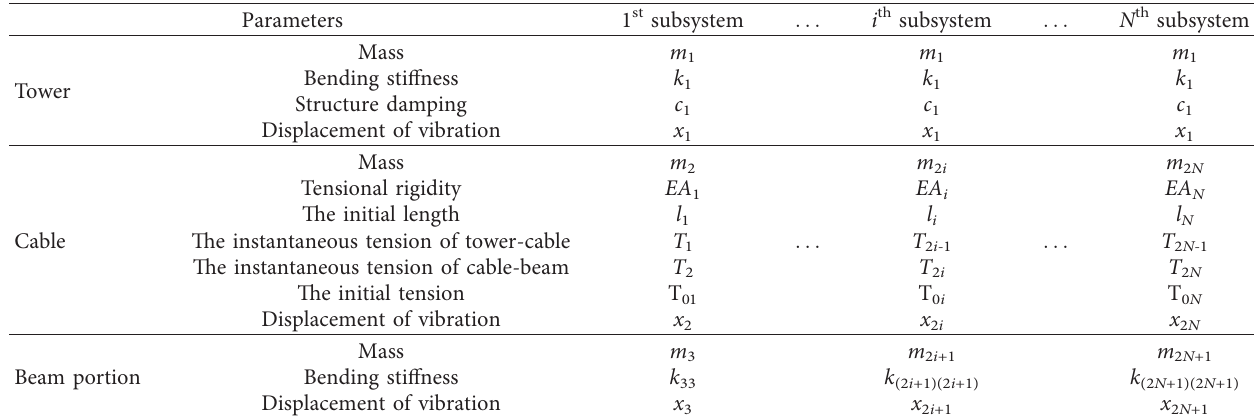
Figure 4: The simplified model for the parametric resonance of the multicable system in cable-stayed bridges. Table 1: Parameters of the refined model (0 ≤ i ≤ N